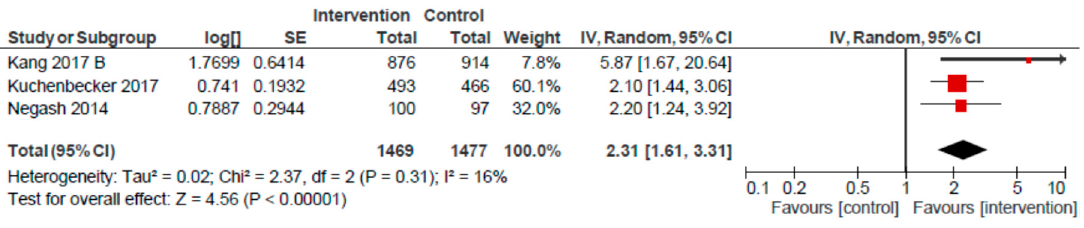
Figure 6. Forest plot of the meta-analysis of exclusive breastfeeding for home visits and mother/peer groups. The impact of the home visit and group session platform on stunting among children < 5 years was 0.97 (95% CI: 0.72, 1.30) across a pooled analysis of eight studies. The impact on < 5 underweight was 0.84 (95% CI: 0.61, 1.14; n = 6). A 23% reduction in the odds of < 5 wasting (OR: 0.77; 95% CI: 0.67, 0.89) was observed across four studies that used the home visit and group platform, compared to usual care (Figure 7). Figure 7. Forest plot of the meta-analysis of child wasting for home visits and mother/peer groups.